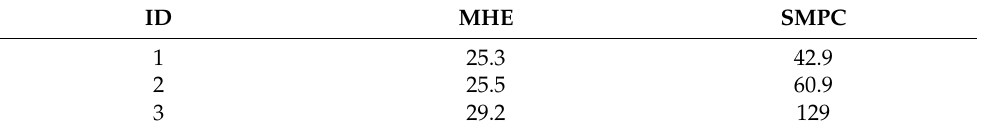
Table 5. Runtime (s) of running the secure federated t -test on each pair of classes as indicated by the ID.